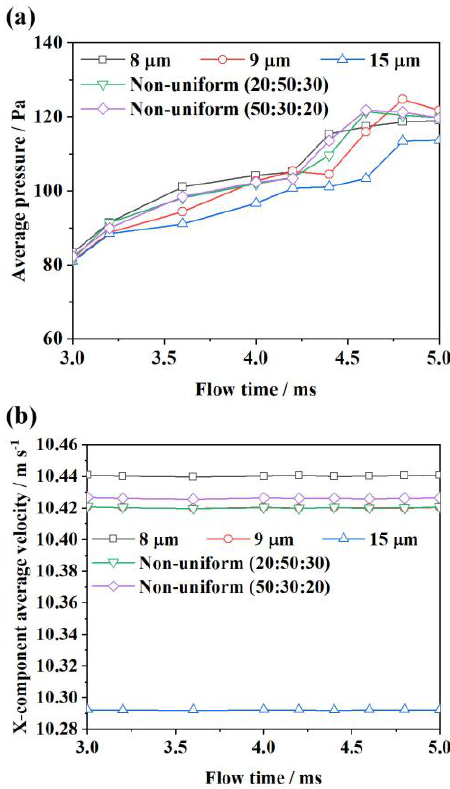
Figure 8. Effect of GDL microstructural arrangement with different fiber diameter on the ( a ) average pressure across channel ( b ) X-component average velocity of the droplet inside channel.